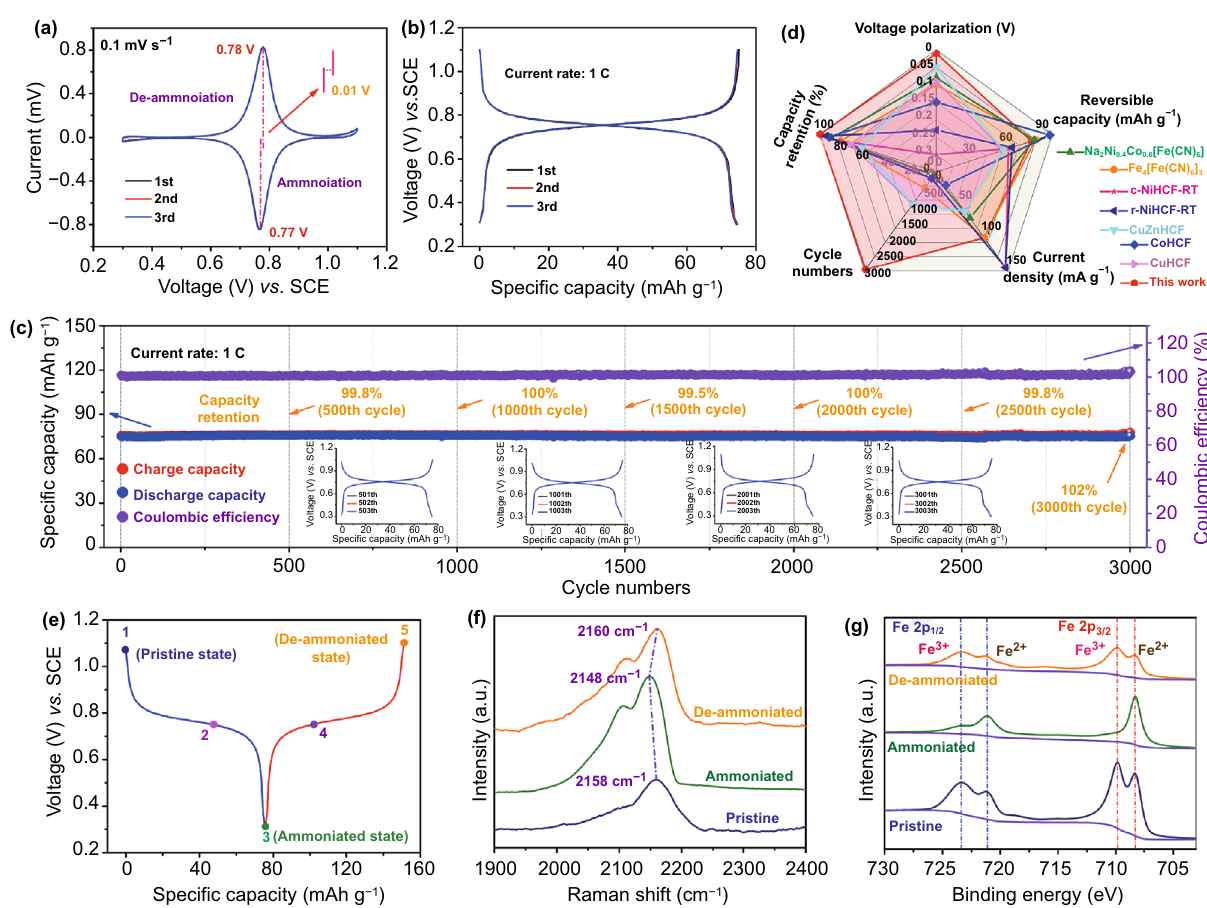
Fig. 3 a First three CV curves at 0.1 mV s −1 . b First three charge/discharge curves at current rate of 1 C. c Long-term cycling performance at 1 C; the insets are the GCD curves at different cycle numbers. d Comparison of cycling performance between the similar PBAs. e GCD curves at different charge/discharge states. f Ex situ Raman spectra of CuHCF electrode at pristine and ammoniated/de-ammoniated states. g Ex situ XPS spectra for Fe 2p at pristine and ammoniated/de-ammoniated